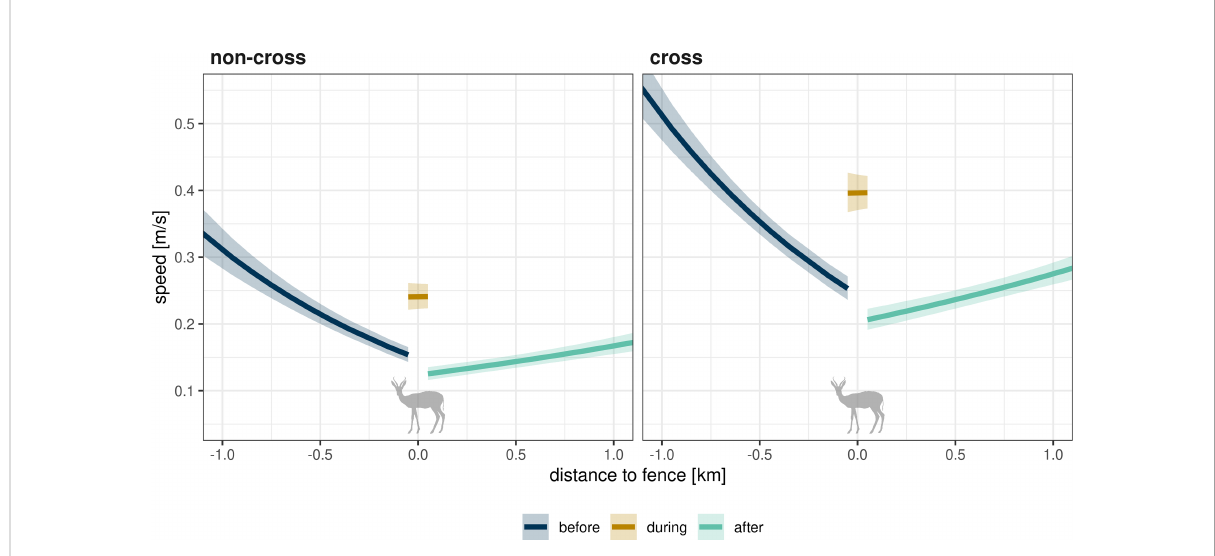
FIGURE 9 With fence encounters associated change in movement speed ( y -axis) along the distance to a fence ( x -axis). Shown is an example prediction for springbok and a quick fence interaction (lag-speed variable kept constant, random effects on population level). Colors depict the prediction for the temporal group (before, during, and after the interaction; see legend). Panels refer to the sub-type of fence interaction (left — non-cross interaction, right — cross interaction). For this presentation, x -values before the interaction were multiplied by − 1, so that the temporal course of the event starts on the left of the axis and ends on the